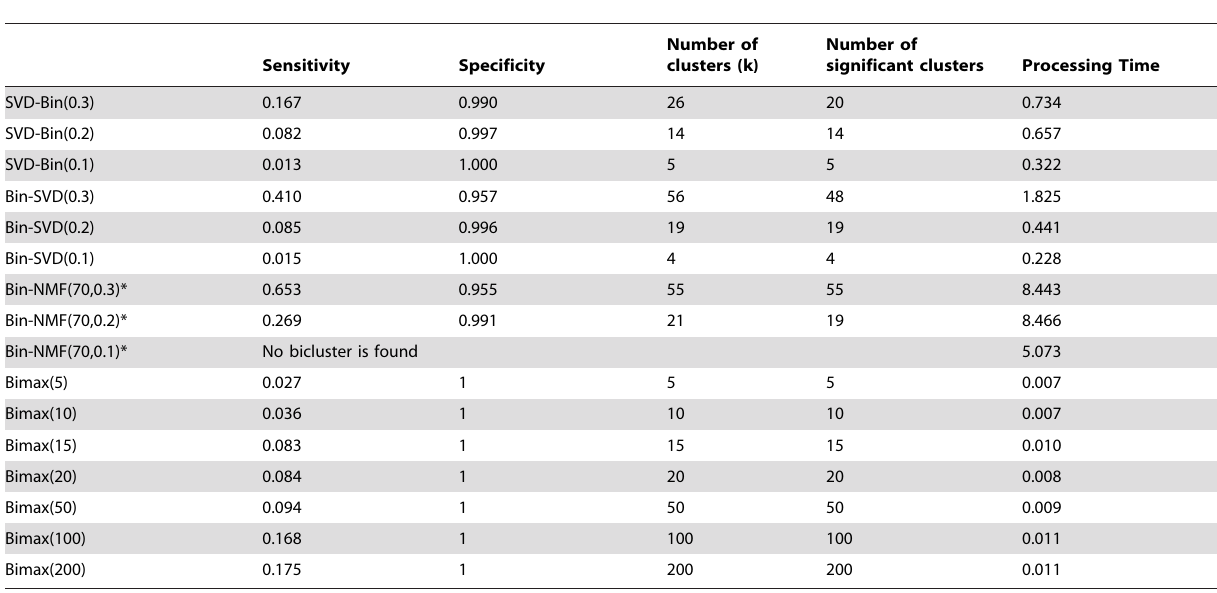
Table 3. Performance of SVD-Bin( d ), Bin-SVD( d ), Bin-NMF( f , d ), and Bimax( k ) on the Saccharomyces cerevisiae dataset where d is the tolerance threshold, f is the number of factorization ranks, and k is the number of clusters.